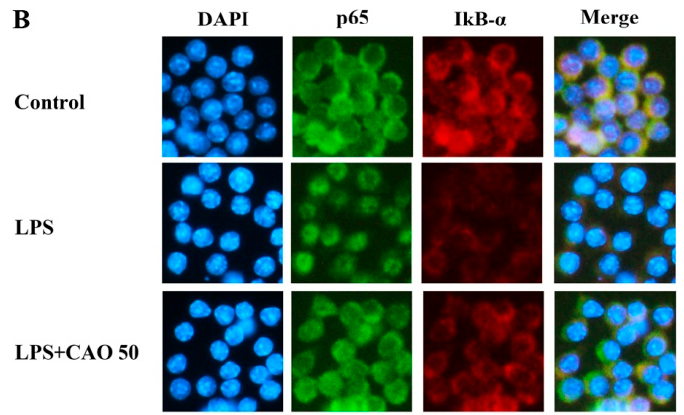
Figure 6. Effects of CAO on the expression of NF- κ B and p-Akt in macrophages. ( A ) The immunofluorescence images show NF- κ B staining (green), p-Akt staining (red), and Nuclei (blue). ( B ) The immunofluorescence images show Nuclei (blue), NF- κ B staining (green), and I κ B- α staining (red). Each image was captured at 400 × magnification. CAO = 50 µ g/mL of callus of A. distichum var. Okhwang 1.